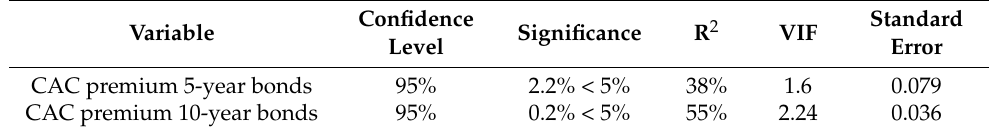
Table 4. Summary findings linear regression and multicollinearity (Source: